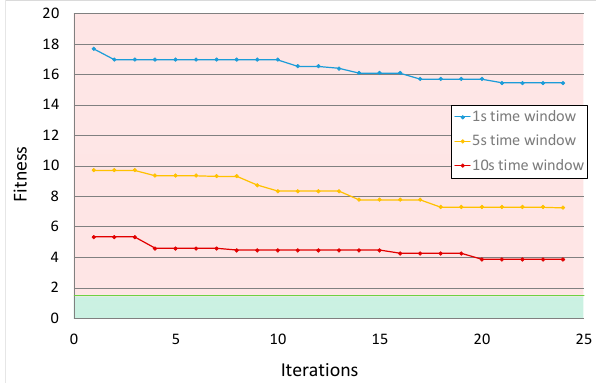
Figure 5. Evolution of the mean value of the fitness of the best solution found by the Genetic Algorithm (GA) for the case of one intermediate timing point.